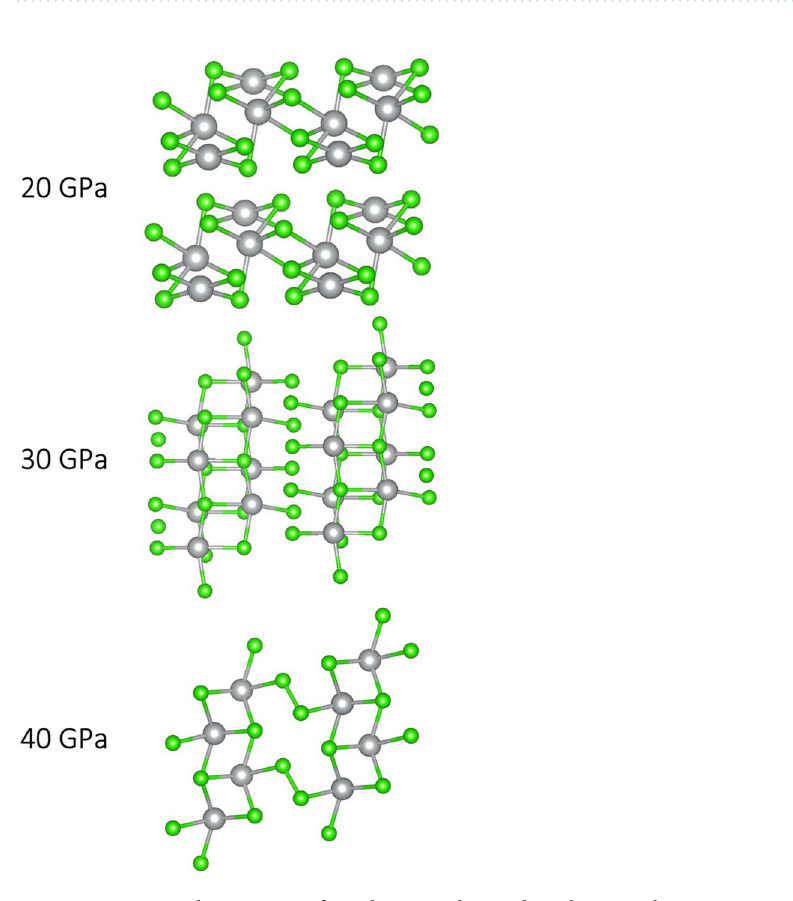
Figure 9. Structural transitions of AuCl 2 -type polymorph in the PBEsol + U